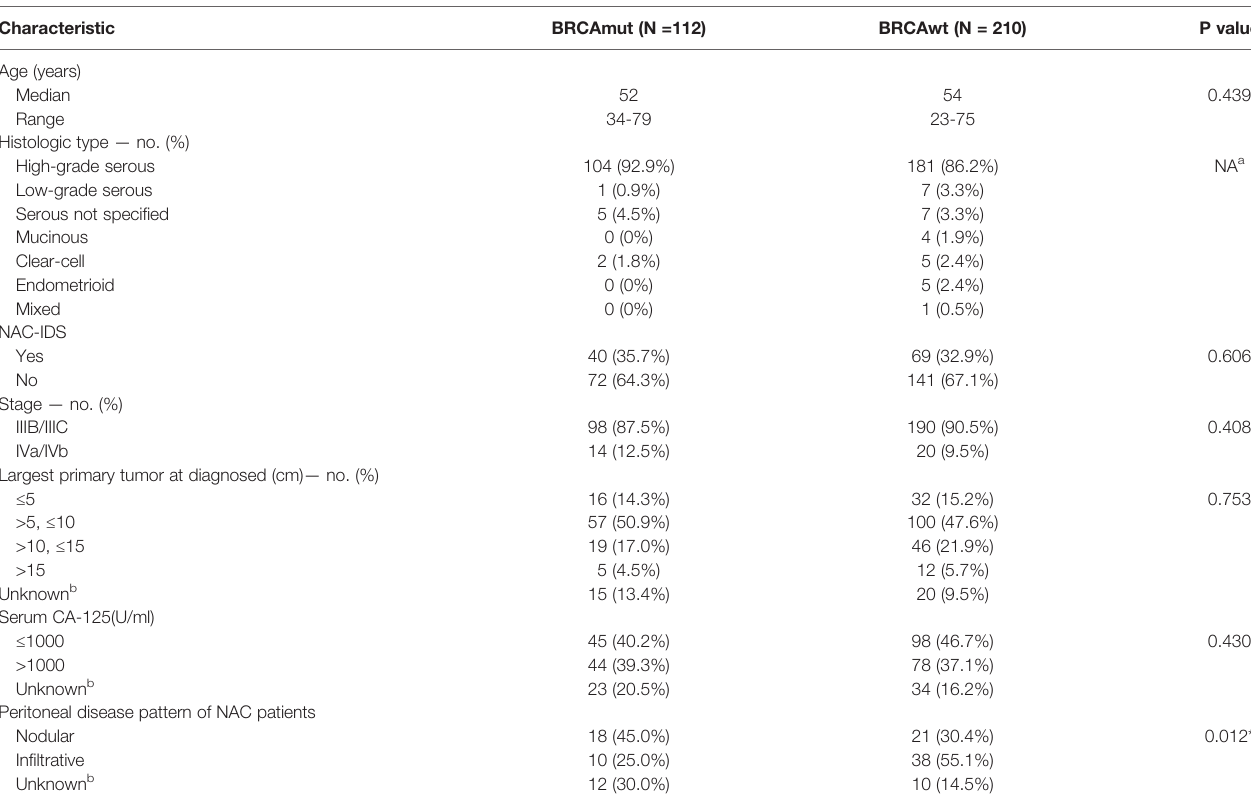
TABLE 2 | Baseline characteristics of all